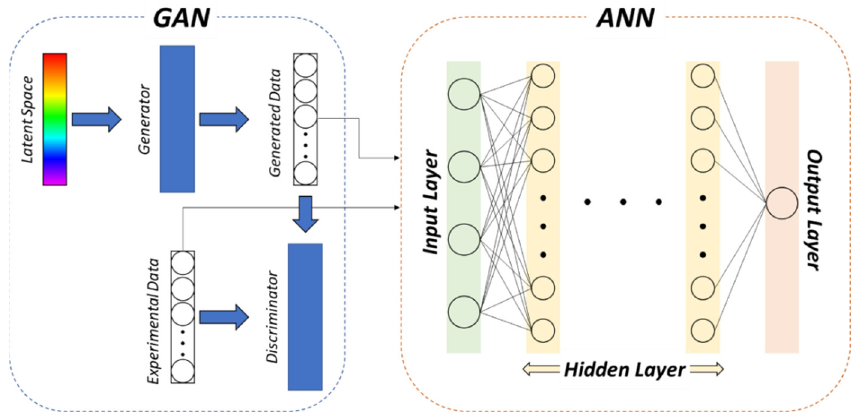
Figure 2. Graphical scheme of GAN-aided ANN model developed in the present study.